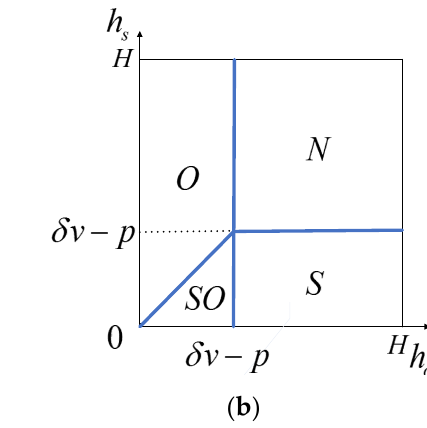
Figure 1. Market segmentation of H-type and L-type consumers when β o + β s ≤ 1. ( a ) H-type consumers; ( b ) L-type consumers.